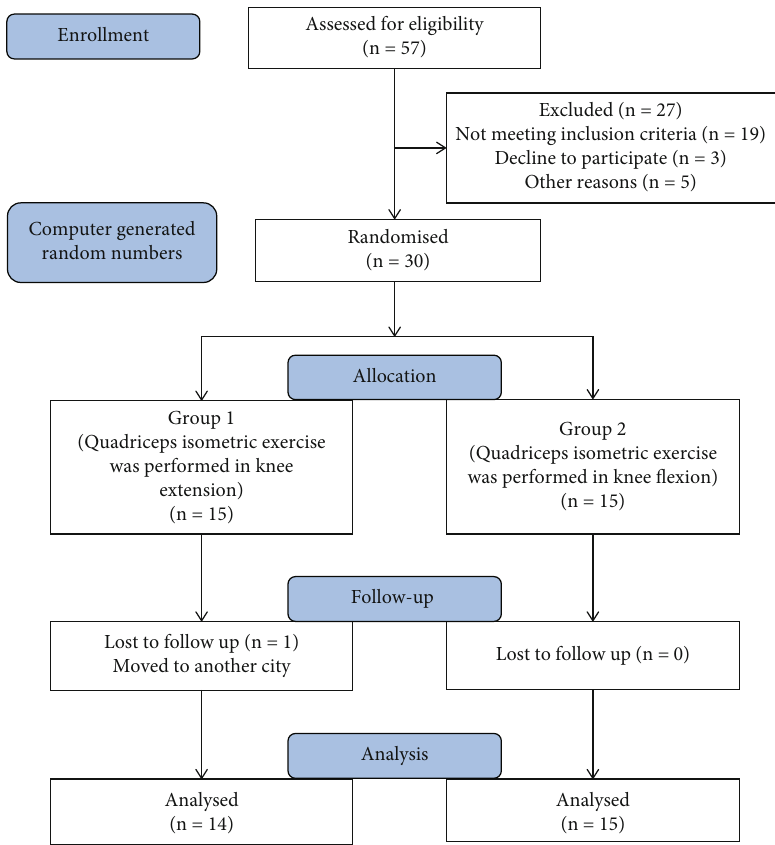
Figure 1: Flow diagram of the study. Table 2: Baseline characteristics of